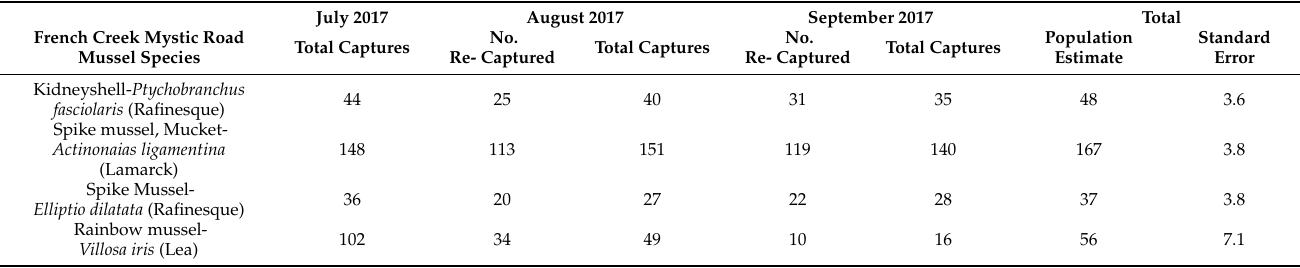
Table 4. Population estimates for the four most common species of mussels at the French Creek Mystic Road sampling site.